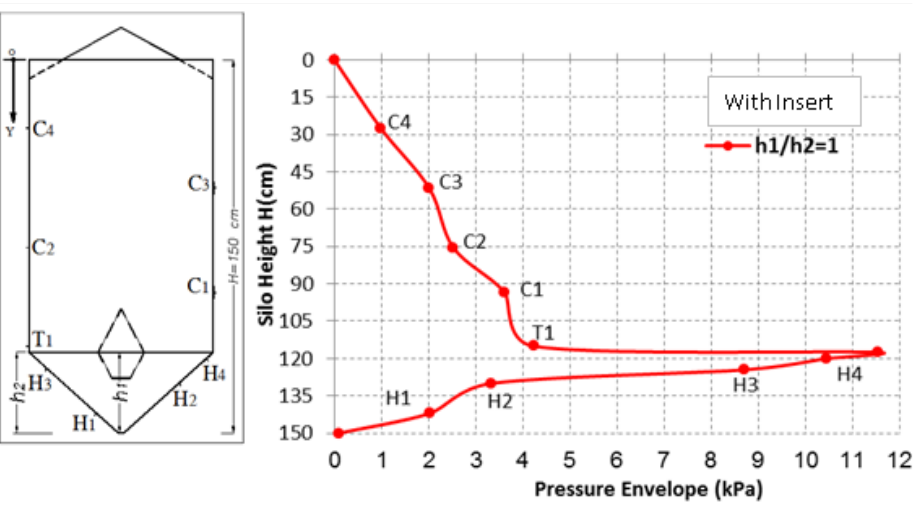
Figure 8: Dynamic horizontal pressure distribution that resulted on the silo wall with insert